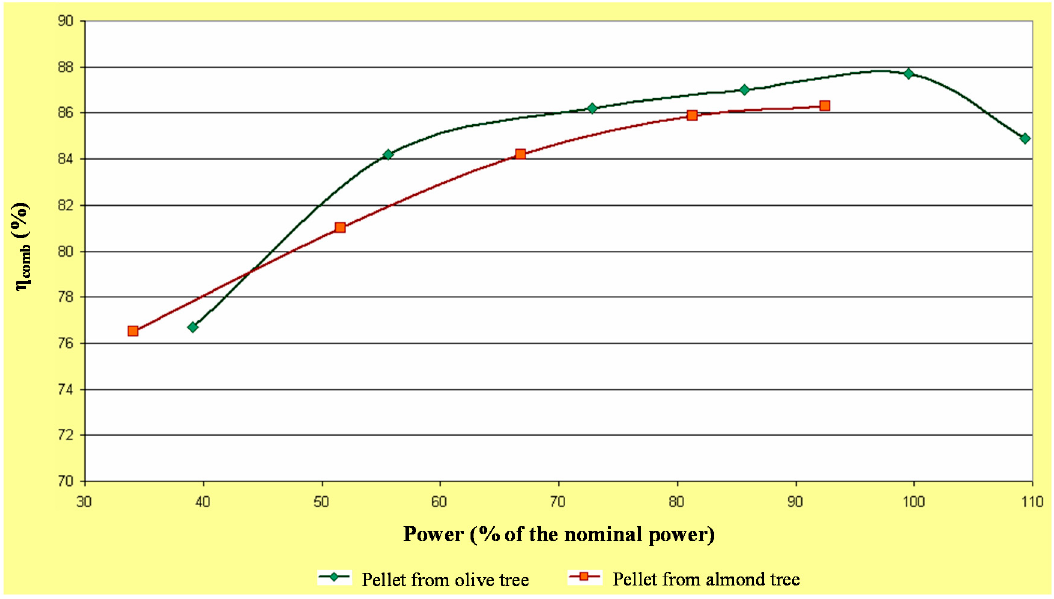
Figure 5. Evolution of combustion efficiency depending on the load for pellets from olive and almond trees.